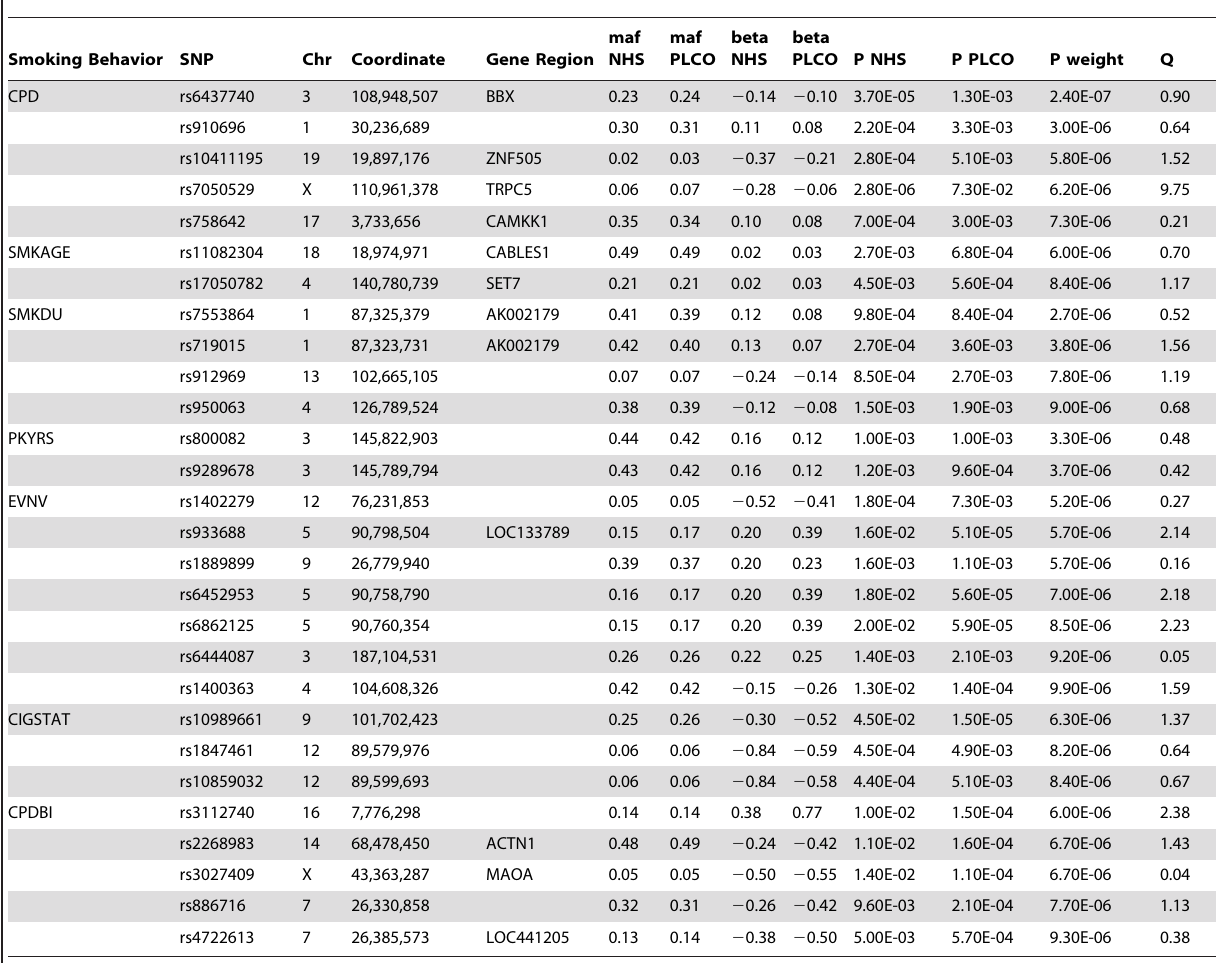
Table 2. SNPs with P weight , 10 2 5 for seven smoking behaviors in 4,611 men and women of European ancestry.